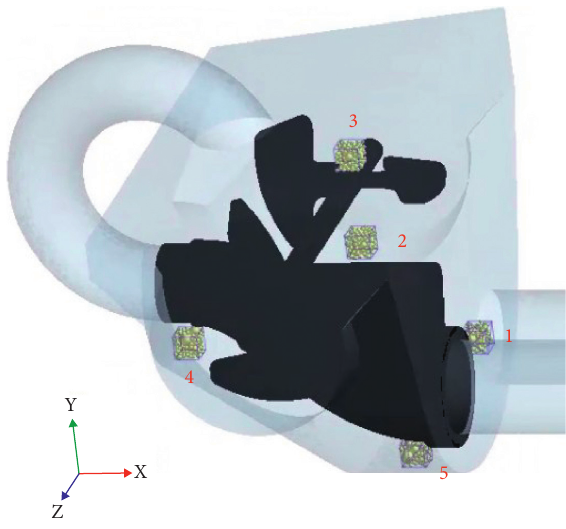
Figure 14: Five typical positions. Table 4: The center coordinates of grids.